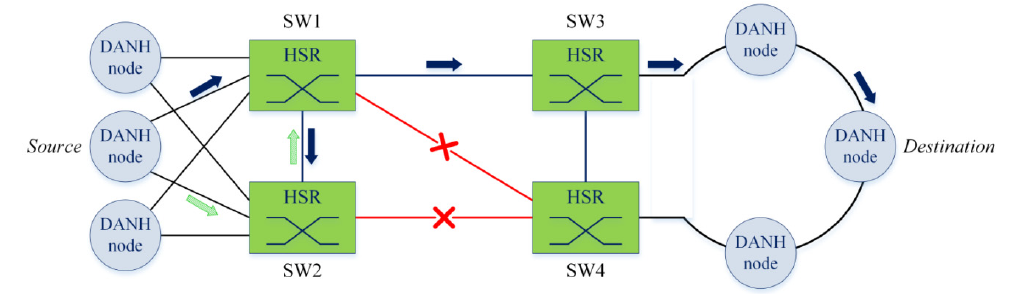
Figure 15. Forwarding a unicast frame in the case of two link failures.